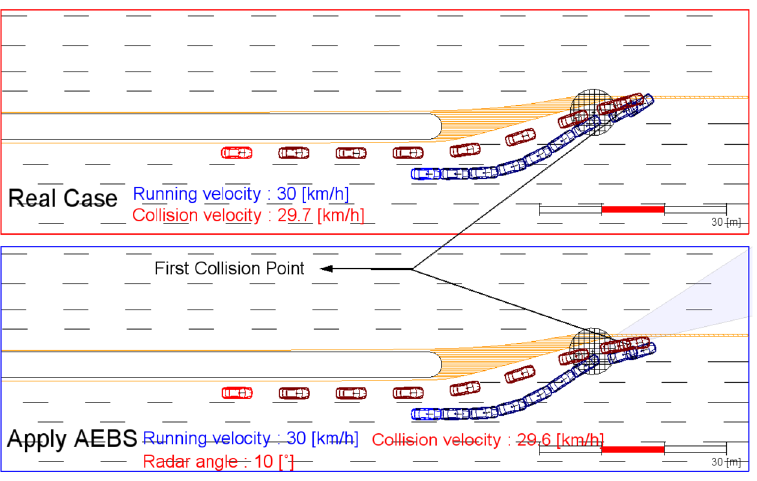
Figure 16. Real Case 4 application of the AEBS.